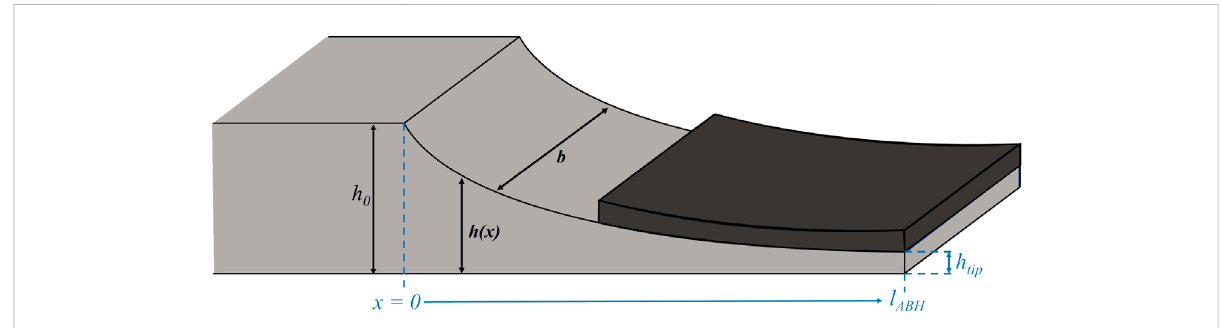
FIGURE 1 ABH beam termination with damping layer showing the beam thickness h 0 , beam width b , ABH length l ABH , ABH thickness pro fi le h ( x ) and ABH tip height h tip